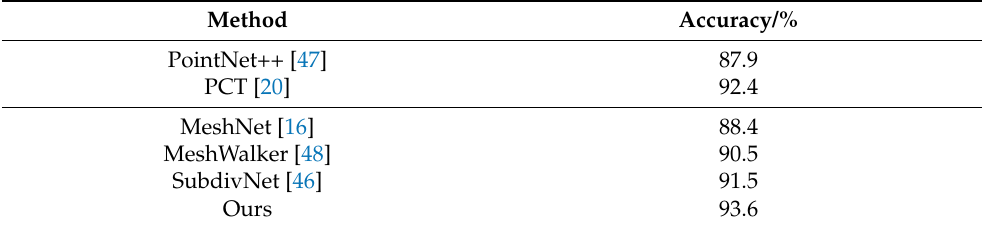
Table 3. Classification accuracy of different methods on